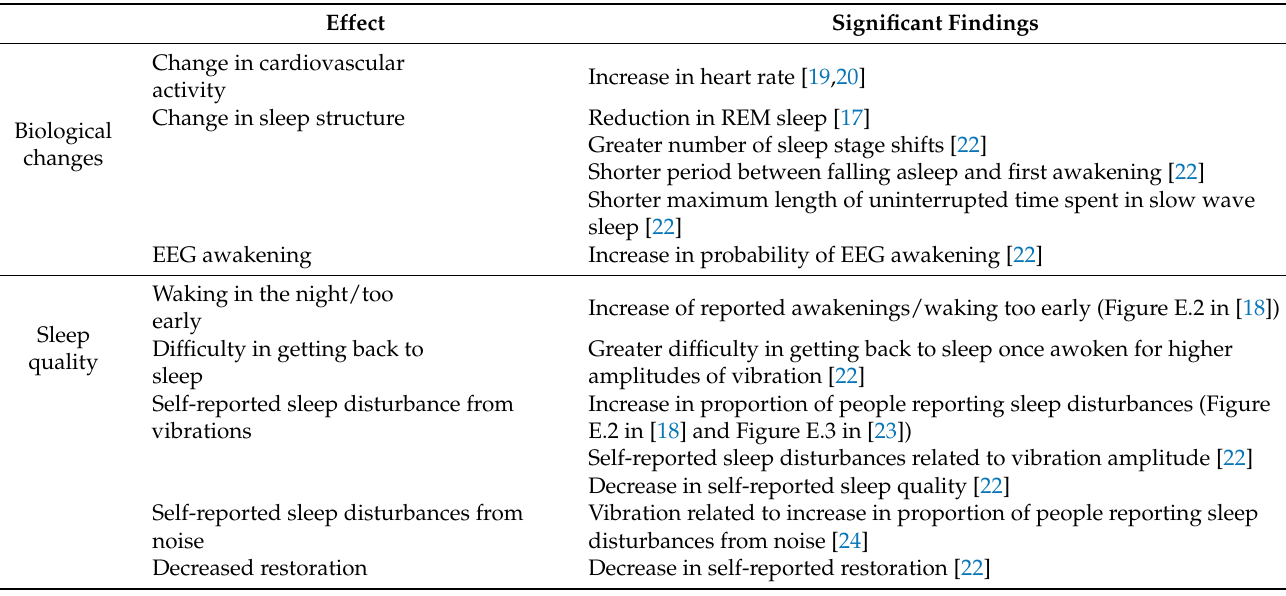
Table 1. Summary of the effects of traffic-induced vibrations on sleep